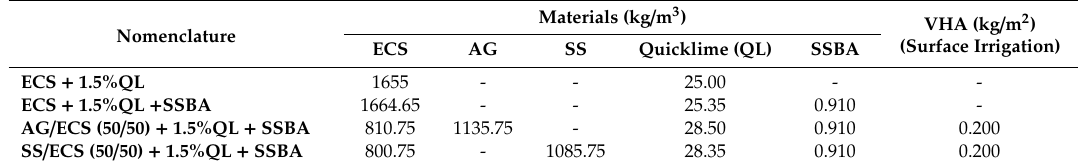
Table 3. Dosages of the mixtures.